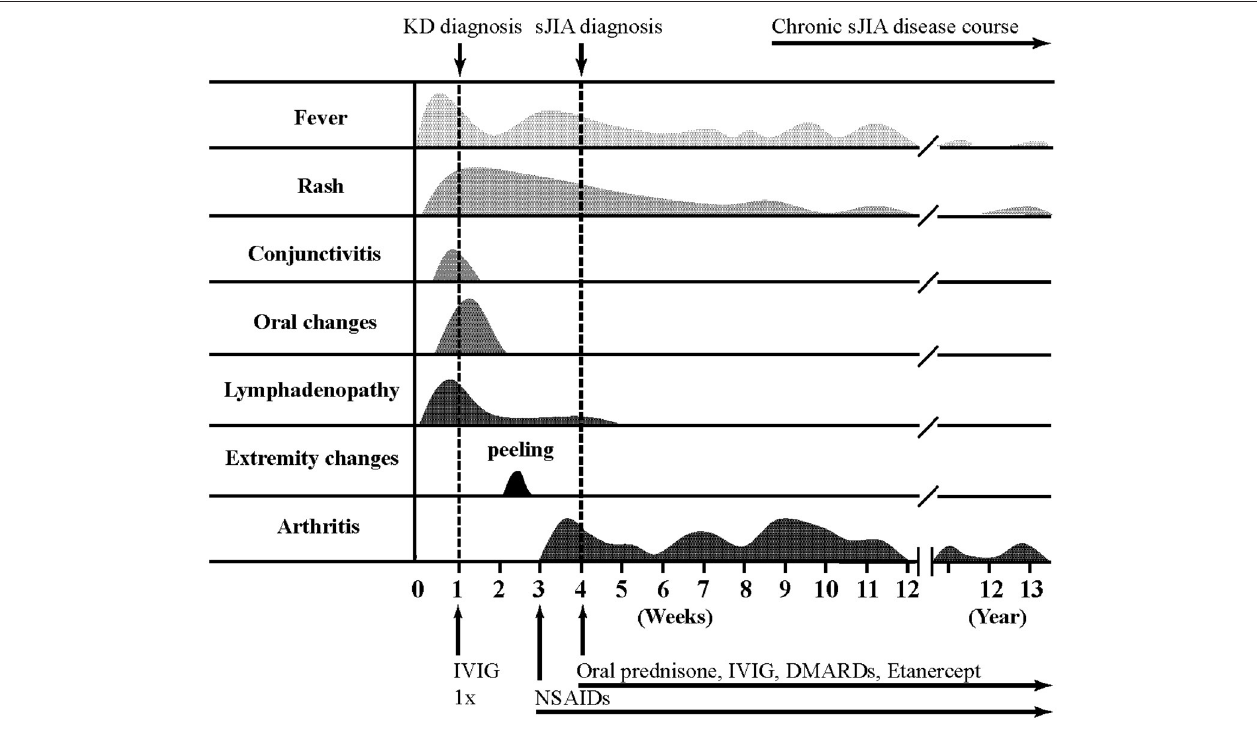
FIGURE 1 | Typical disease course of Kawasaki disease-systemic juvenile idiopathic arthritis.